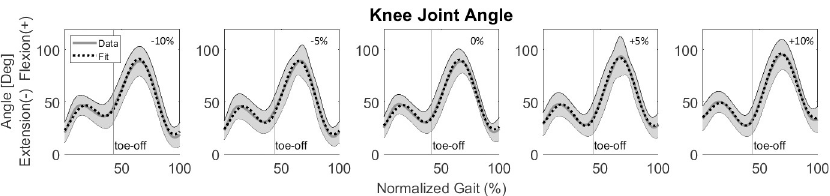
Fig 2. Stage 1: Sagittal knee joint angle as an example of the Fourier series fit for each surface gradient while running at 2.25 m/s using the linear formulation. The dotted line represents the fit, while the gray line represents the average of all participants. The gray shading is the between-participants variability, represented with one standard